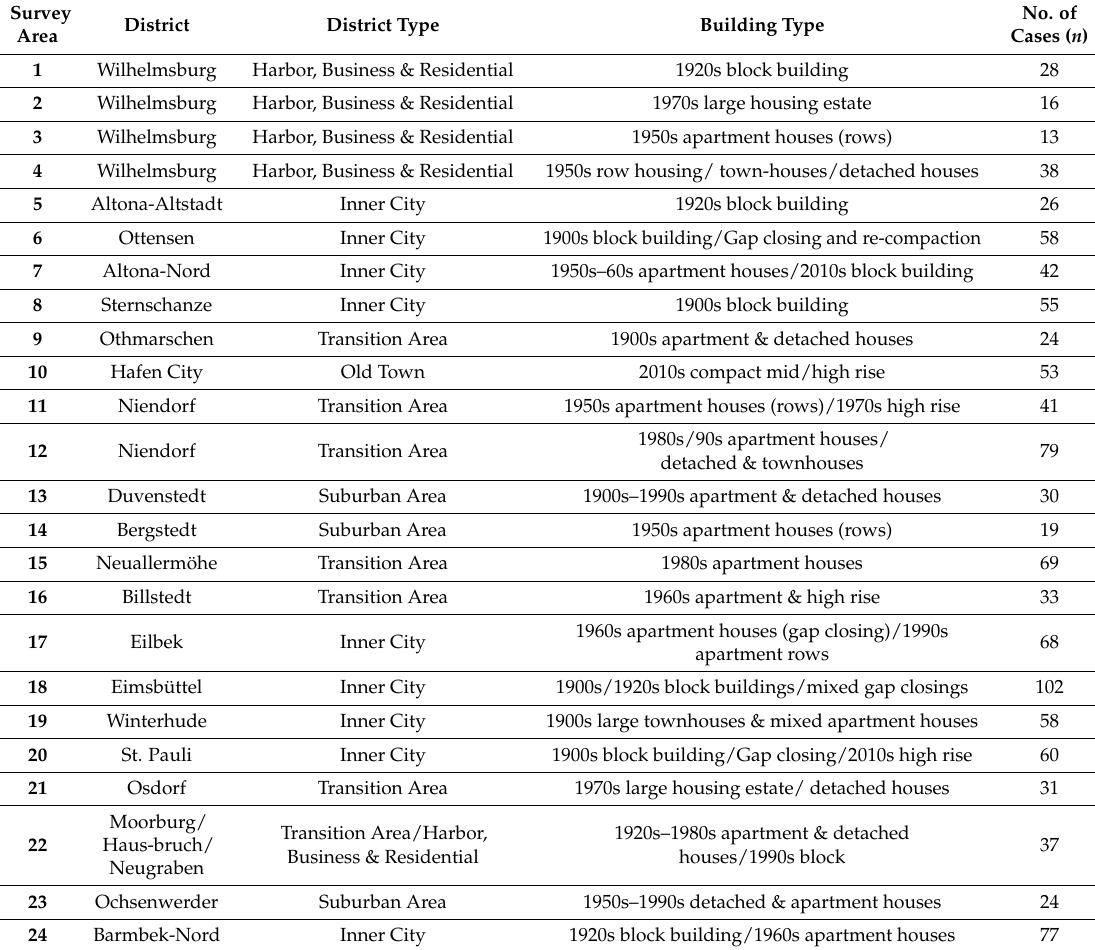
Table 2. Overview of the survey areas: district, district type, and building types. Survey